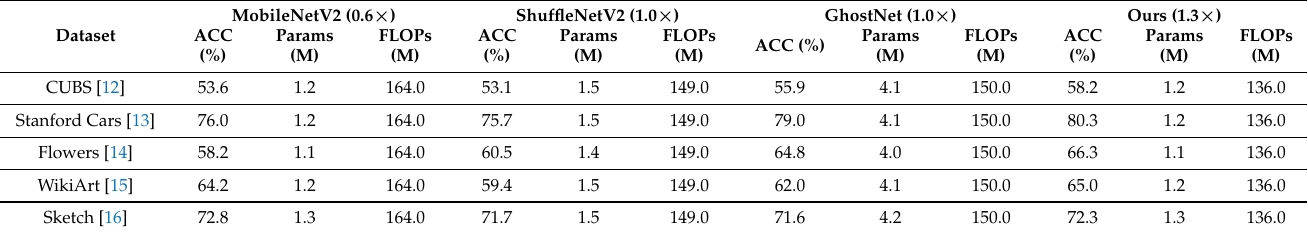
Table 5. Performance of the compared methods on the large-scale datasets.